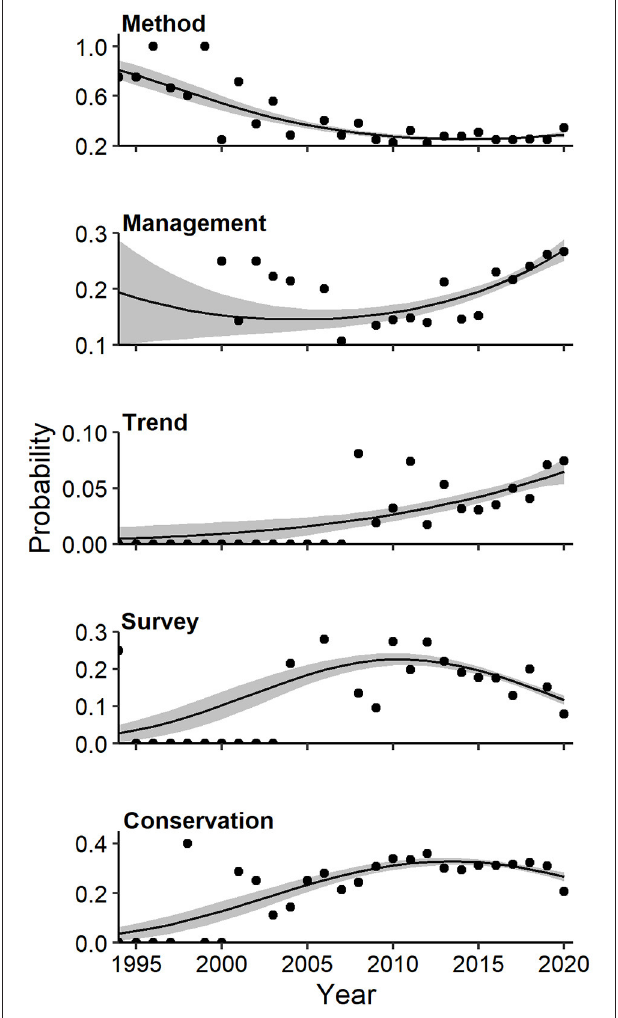
FIGURE 7 | Effects plots of multivariate regression for themes of camera-trapping studies that exhibited temporal trends ( P < 0.10) in probability of occurrence. Shaded regions represent standard errors and points represent observed annual